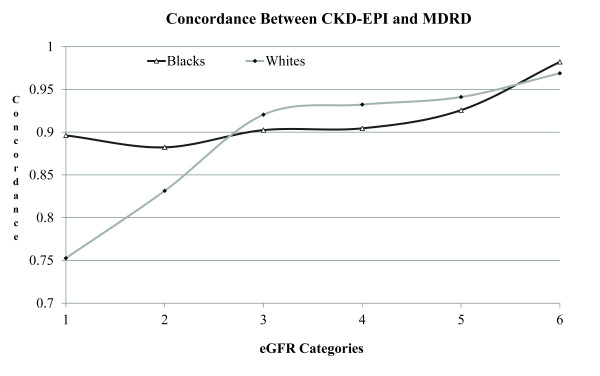
Concordance between MDRD and CKD-EPI equations in black and white individuals according to eGFR categories. On the X axis, in ml/min, categories 1-6 correspond to the following eGFRs (ml/min): 1 = > 90, 2 = 60-89, 3 = 45-59, 4 = 30-44, 5 = 15-29, and 6 = < 15.